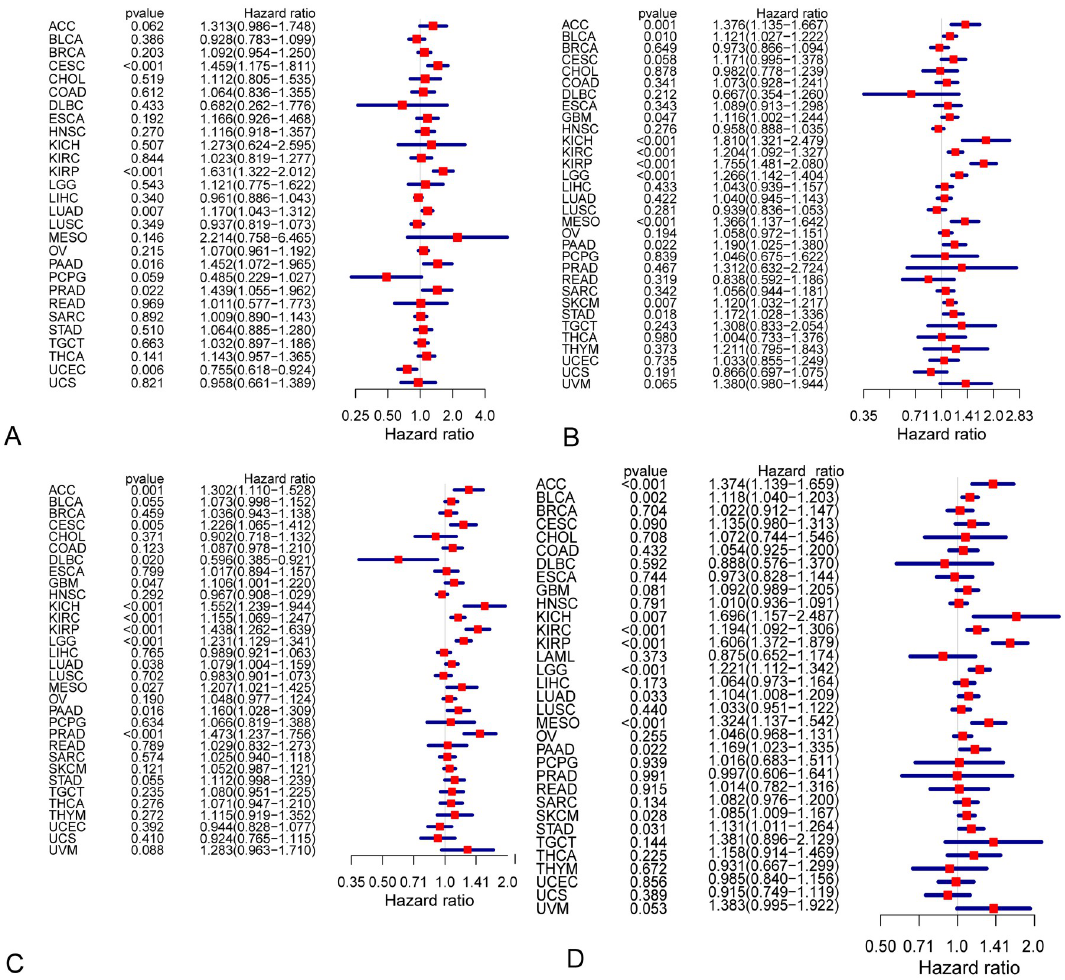
Fig 3. Survival curves and cox proportional hazards regression model of DFI, DSS, and PFI in different types of cancers. (A-C) Cox proportional hazards regression model of DFI, DSS, and PFI. (D) Cox proportional hazards model of OS in LGG for expression of COL1A1. DFI, disease free interval.